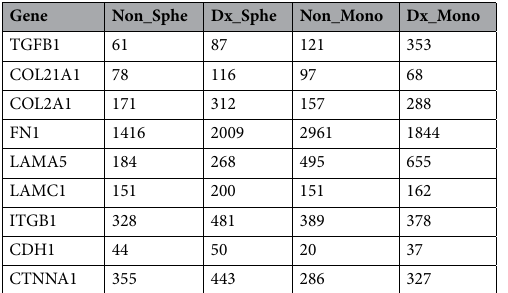
Table 1. Differentially expressed genes (fpkm). Sphe spheroid, Mono monolayer